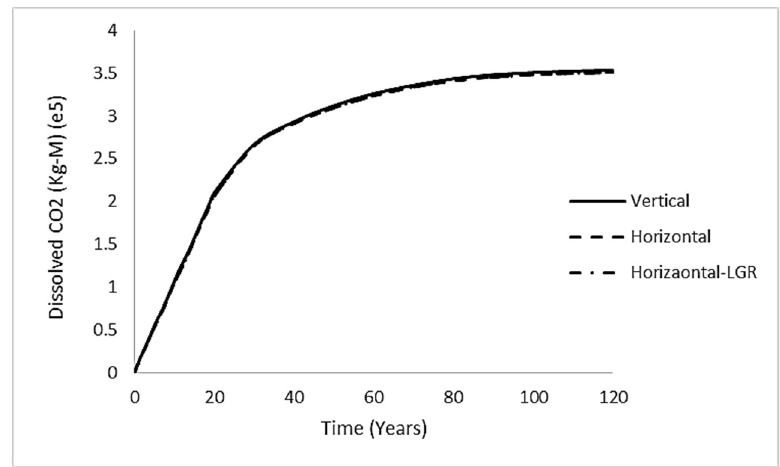
Figure 12. Simulation result for the effect of vertical and horizontal wells on CO 2 dissolution in brine.